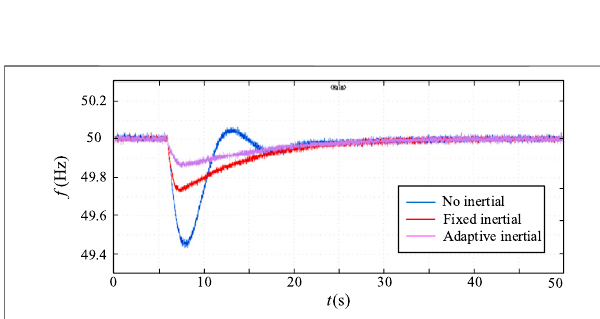
FIGURE 12 | System frequency under different